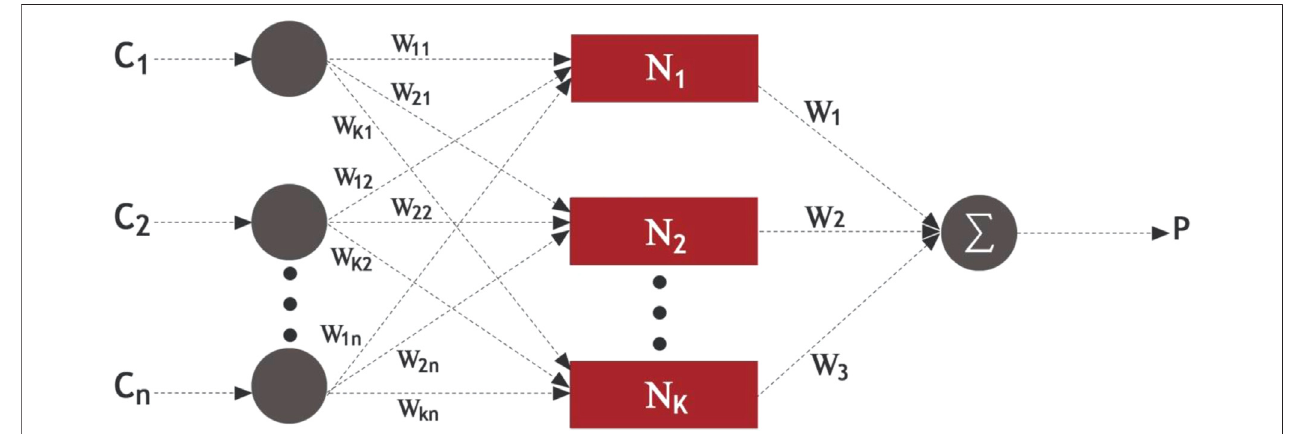
FIGURE 3 | Structure of the RBF model (Ramezanizadeh et al.,